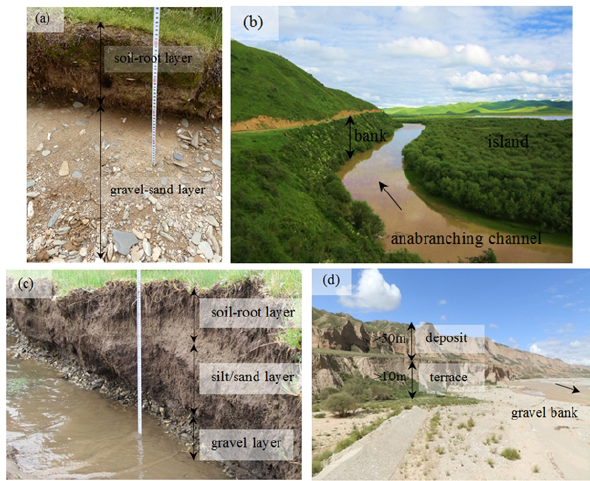
Figure 3. River bank of the study reaches (a) Dari reach, (b) Maqu reach, (c) Lanmucuo River reach, and (d) Daheba River